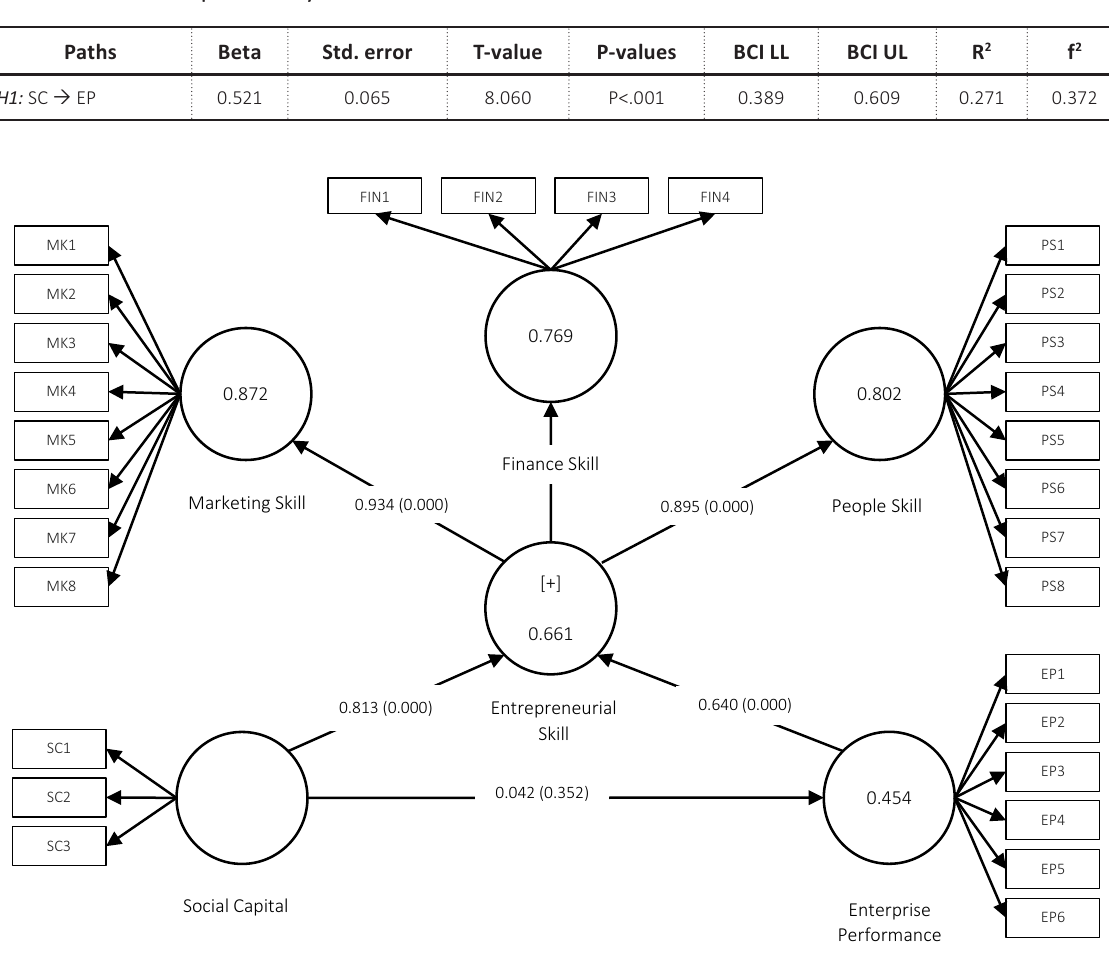
Figure 2. Research model with mediation